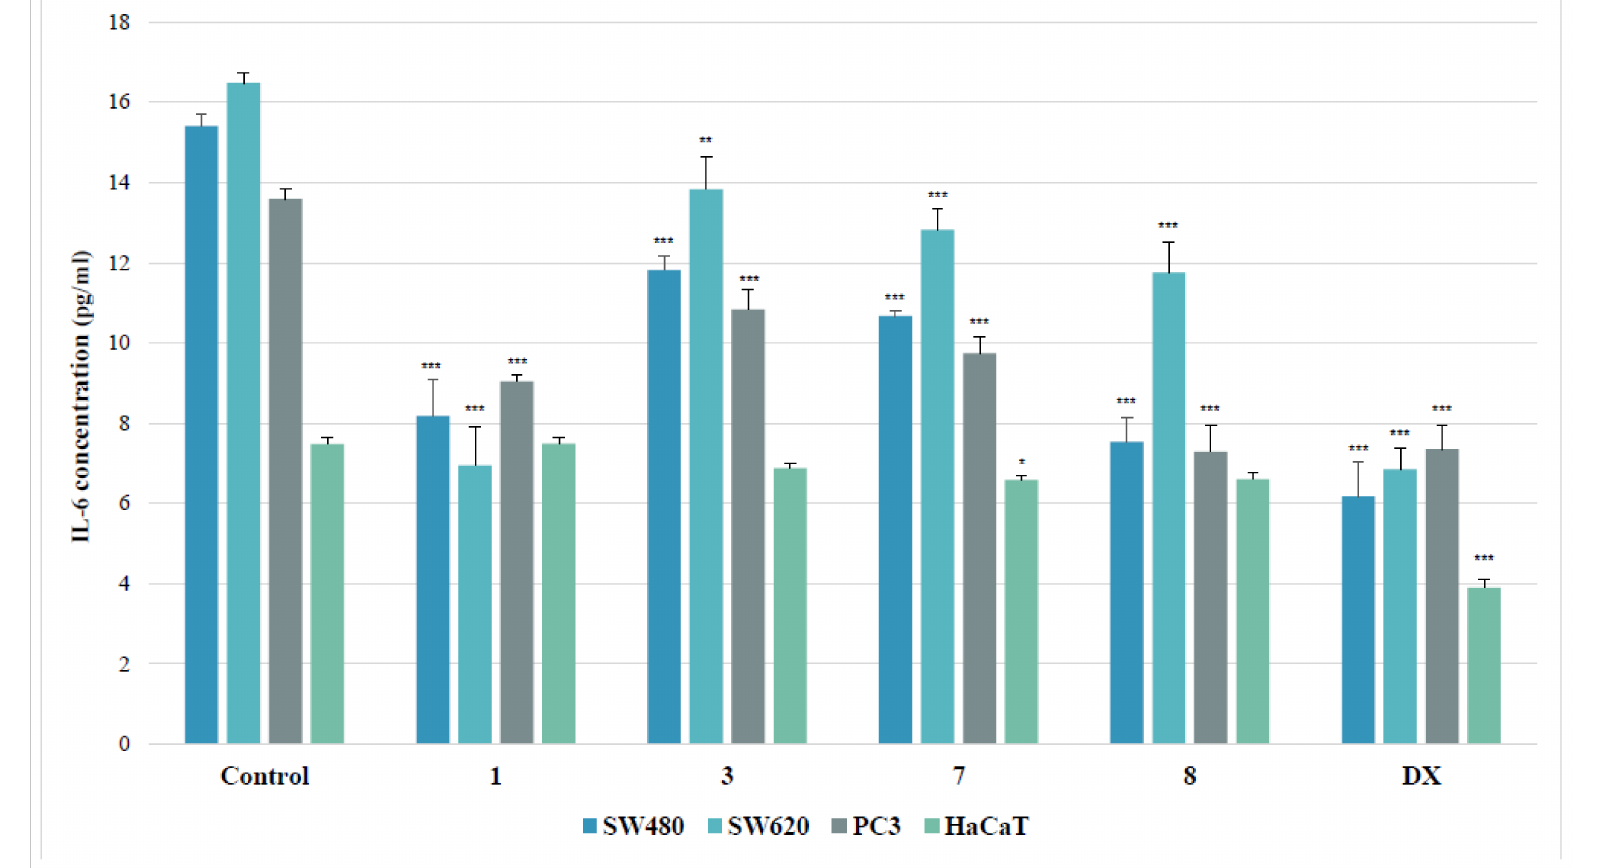
Figure 7. Effects of thiourea complexes 1 , 3 , 7 and 8 on IL-6 levels, measured by enzyme-linked immunosorbent assay (ELISA) test. Data are expressed as the mean ± SD from three independent experiments performed in triplicate. *** p ≤ 0.001, ** p ≤ 0.01, * p ≤ 0.05, as compared to the control. DX (doxorubicin) is the reference